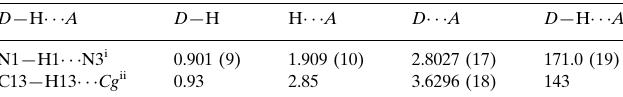
Hydrogen-bond geometry (A˚ , (cid:4) ). Cg is the centroid of the C11–C16